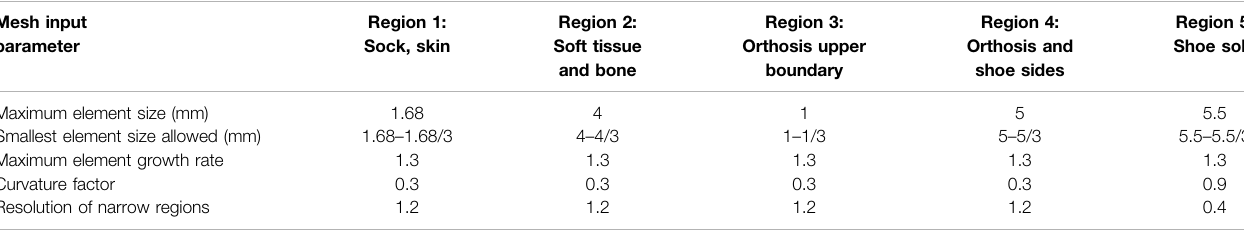
TABLE A1 | Mesh input parameters.